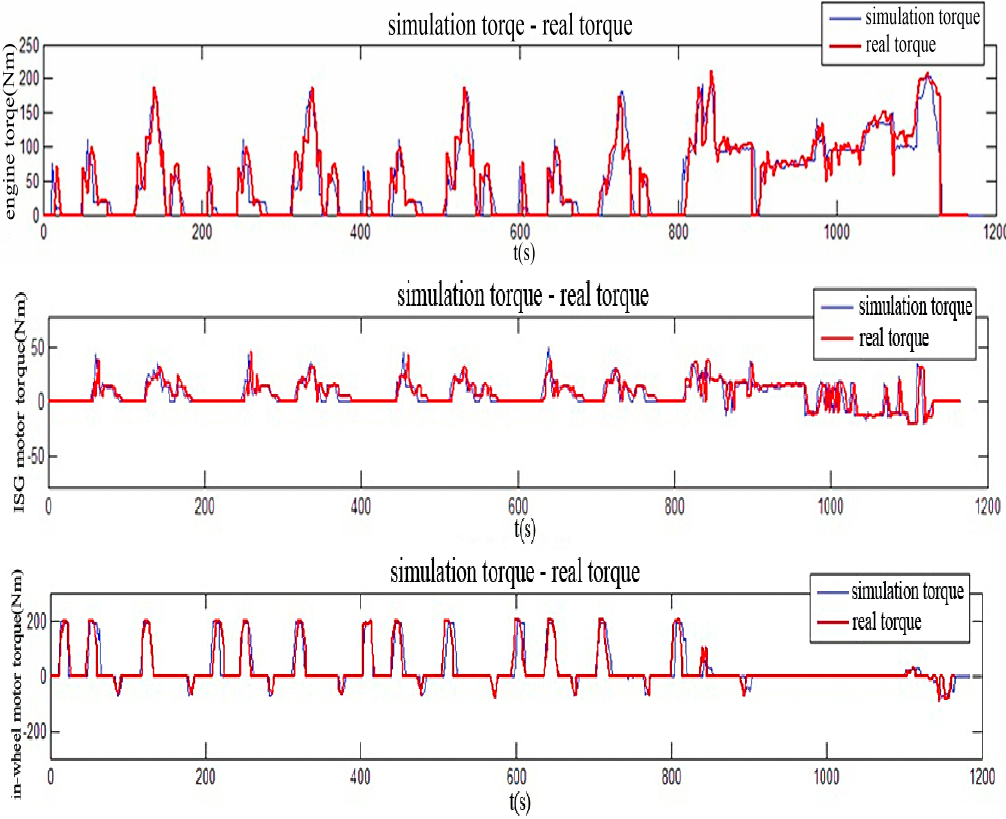
Figure 14. Driving cycle tracking and engine speed comparison of offline simulation and drum bench test in NEDC.